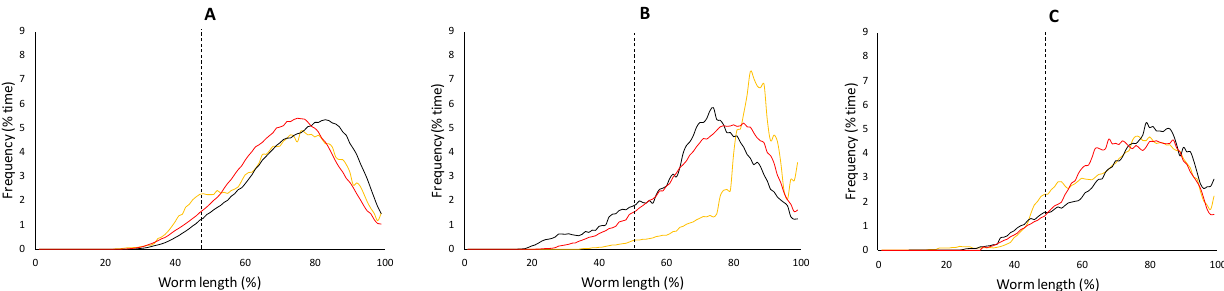
Figure 4. Example of the effect of nitrite and ascorbic acid on the raw postural spectra. ( A ): nematodes with no nitrite exposure; ( B ): nematodes at 3000 mg/L nitrite; ( C ): nematodes 5 mM ascorbic acid/3000 mg/L nitrite. Dotted lines mark the turns (0 – 50 %) and runs (50 – 100%) zones. AA: yellow; PA black; PP: red.